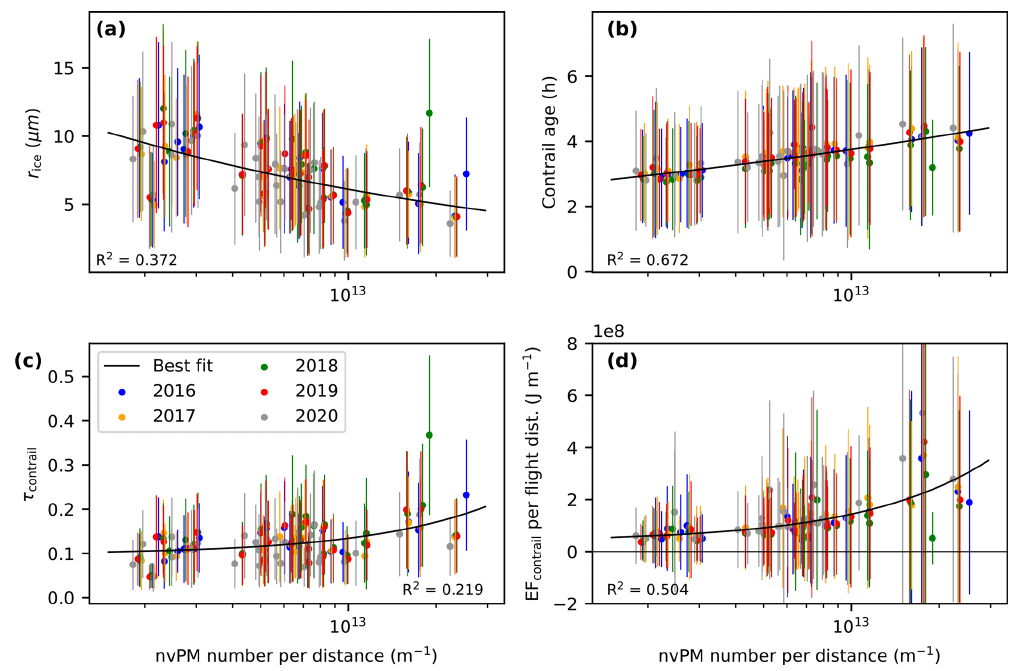
Figure 5. The (a) contrail ice crystal radius (r ice ), (b) age, (c) optical depth ( τ contrail ) and (d) EF contrail per flight distance vs. nvPM number emissions per distance travelled. Each data point represents the annual mean values for different aircraft types, and the error bars represent 1 standard